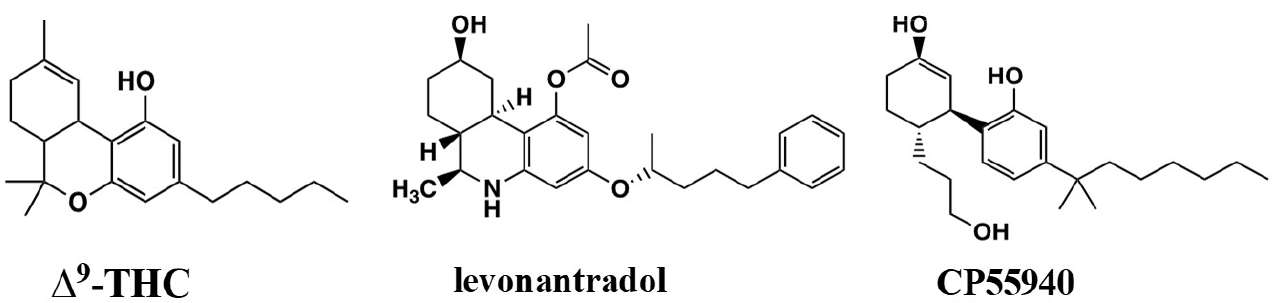
Figure 1. Classical cannabinoids Δ 9 -tetrahydrocannabinol (THC) and levonantradol and non-classical A,C-bicyclic cannabinoid CP55940.